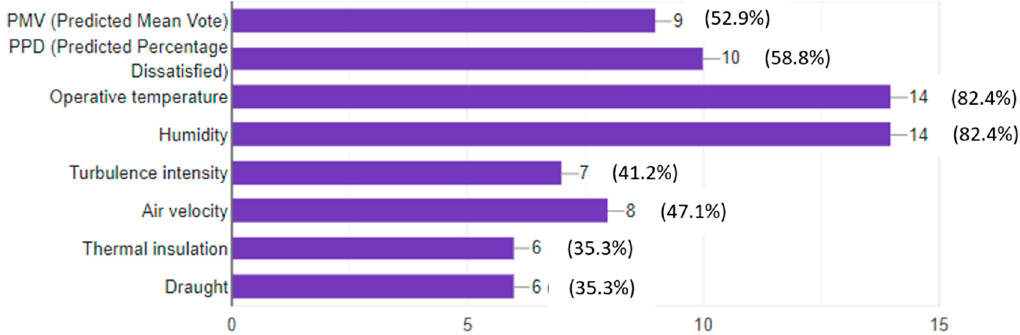
Figure 3. Which of the following indicators are you familiar with?